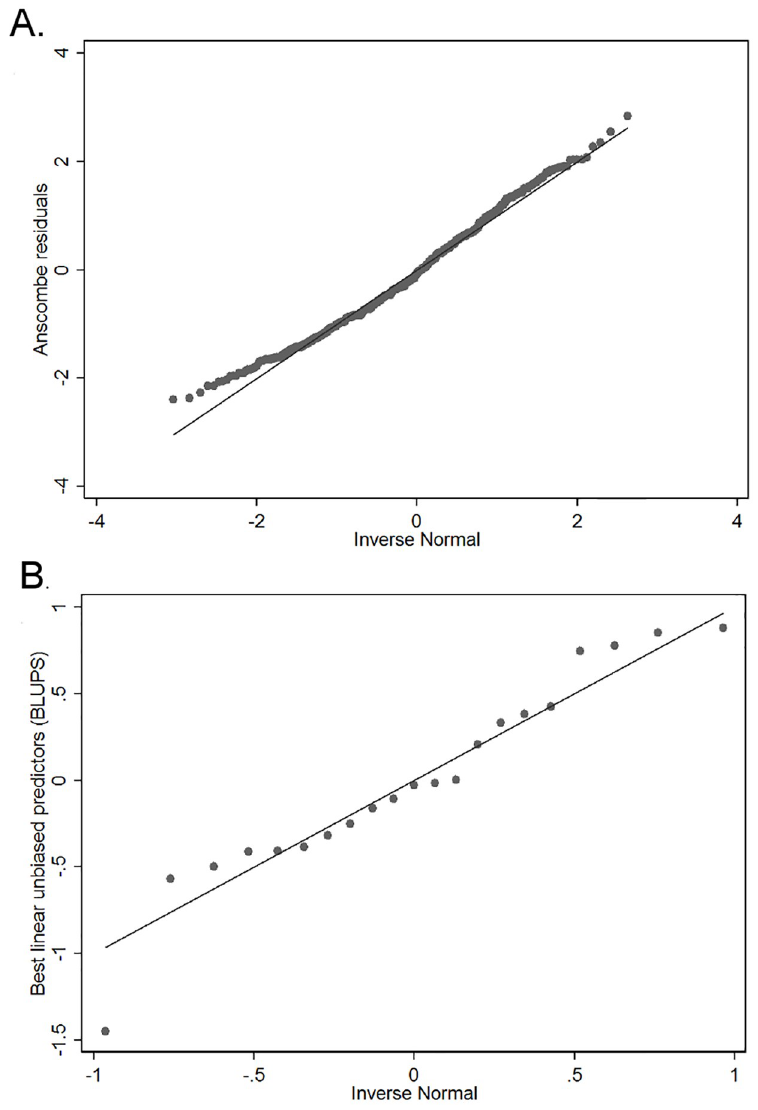
Fig 6. Normal quantile plots for Ascombe residuals (A) and best linear unbiased predictors (BLUPS; B) for the generalized mixed Poisson model used to model the association between demographic and environmental variables of interest and the occurrence of PRRS outbreaks in sow farms across the United